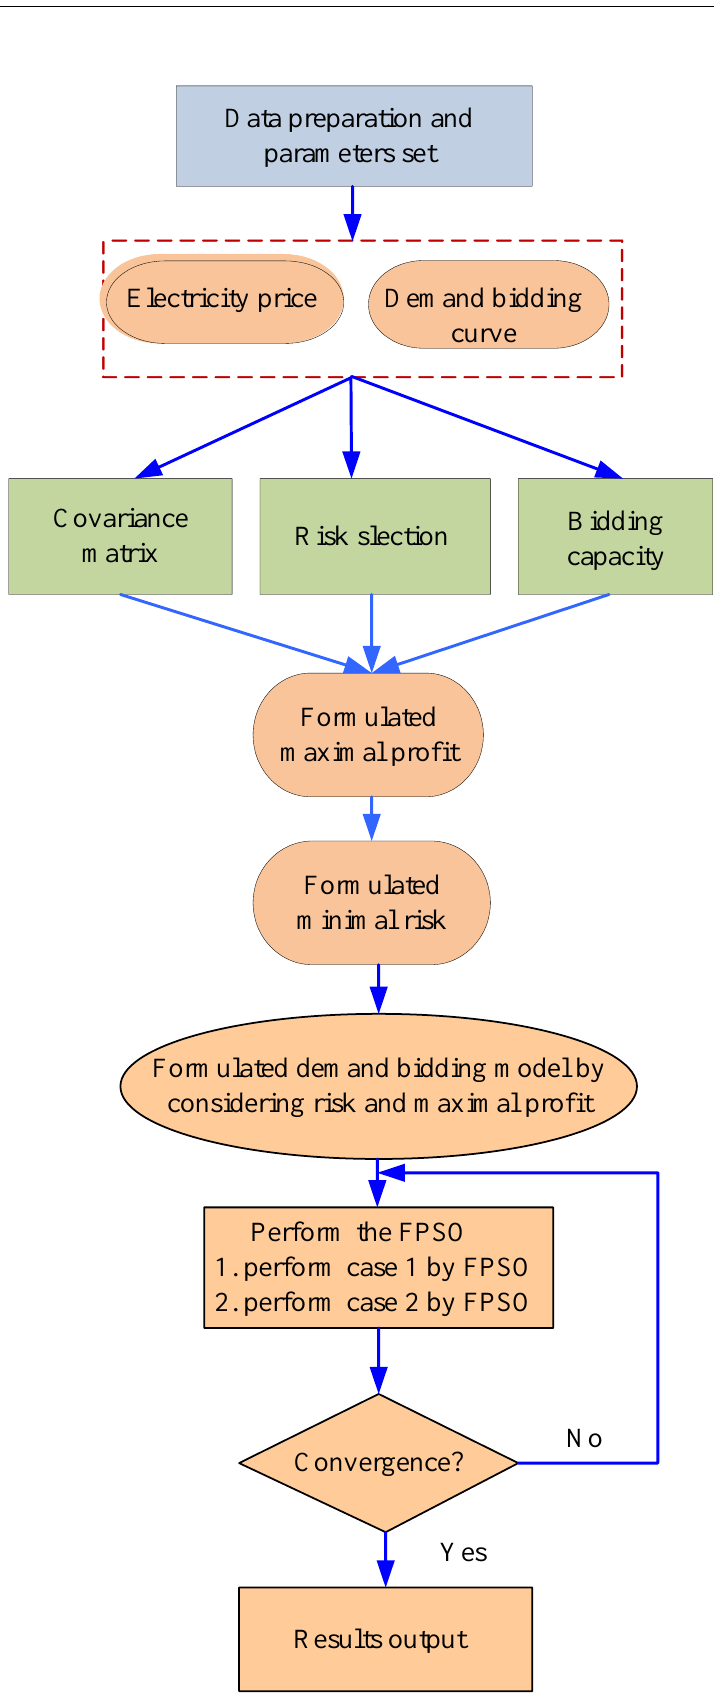
Figure 2. Flowchart of the solution algorithm.